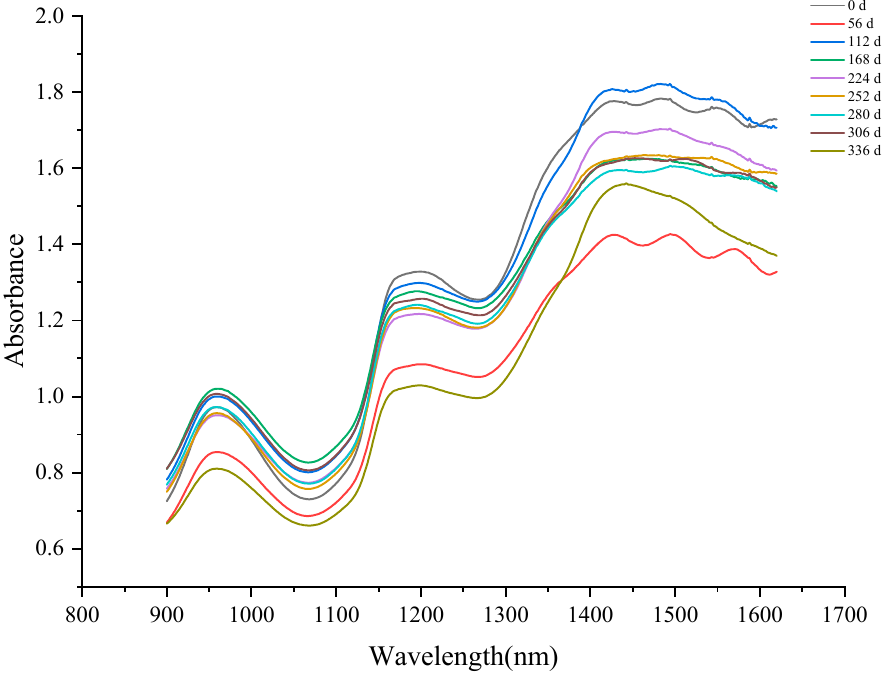
Figure 6. NIR analysis of Sichuan sauerkraut during storage.